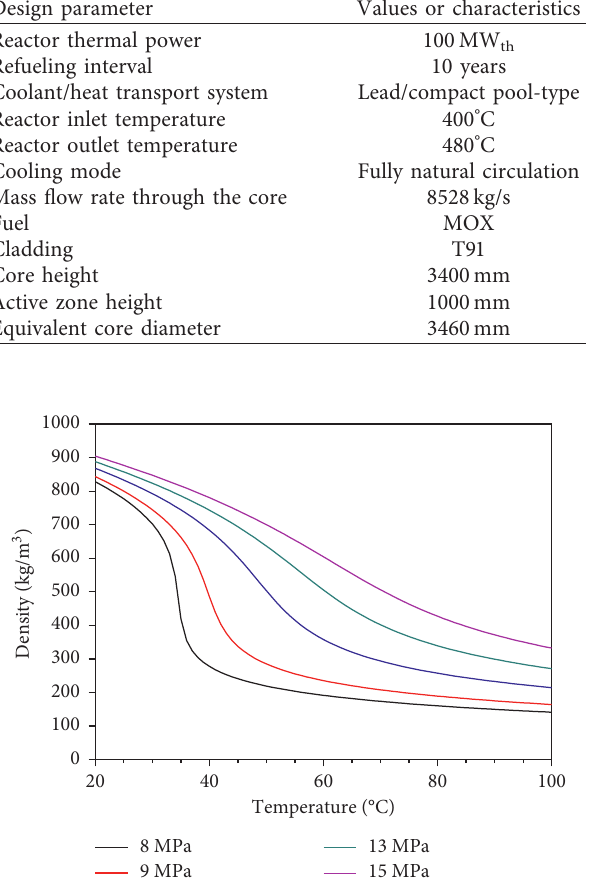
Table 1: Main design parameters of SNCLFR-100 [13]. Design parameter